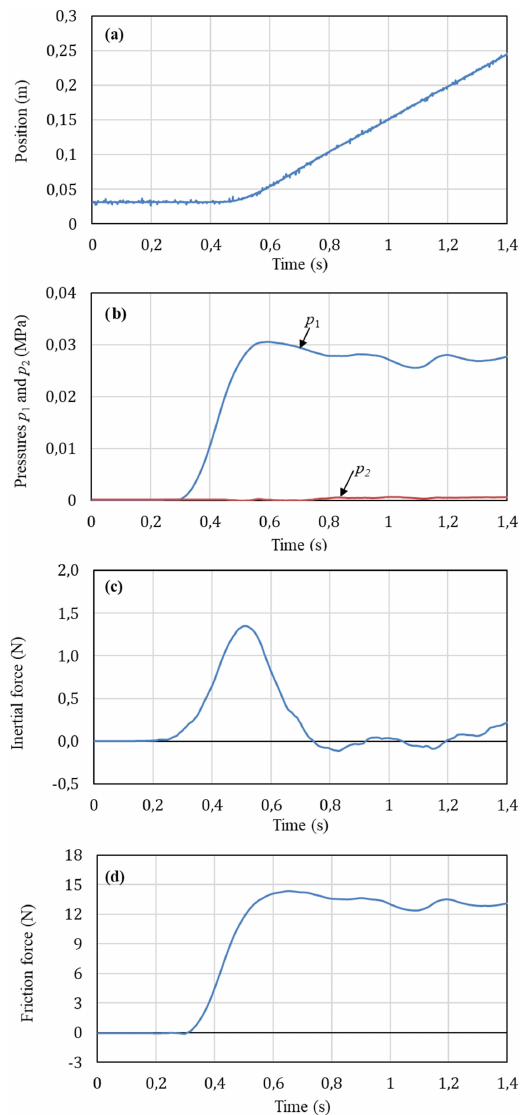
Figure 9. Experimental characteristics at operating conditions of u 1 = 2 . 5 + 0 . 5sin(2 πf t )(V), u 2 = 2 . 5 − 0 . 4sin(2 πf t )(V), f = 0 . 2Hz, M = 1 . 3kg: (a) piston position, (b) pressures in the cylinder chambers, (c) initial force, (d) friction